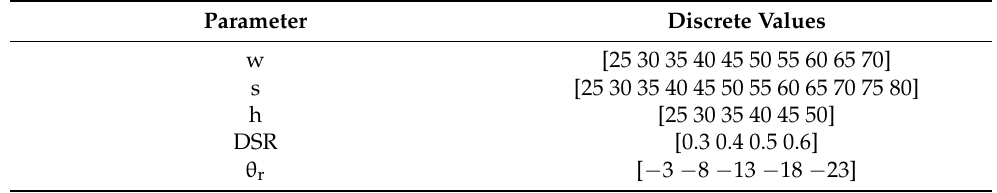
Table 7. Discrete values of parameters in the action space.